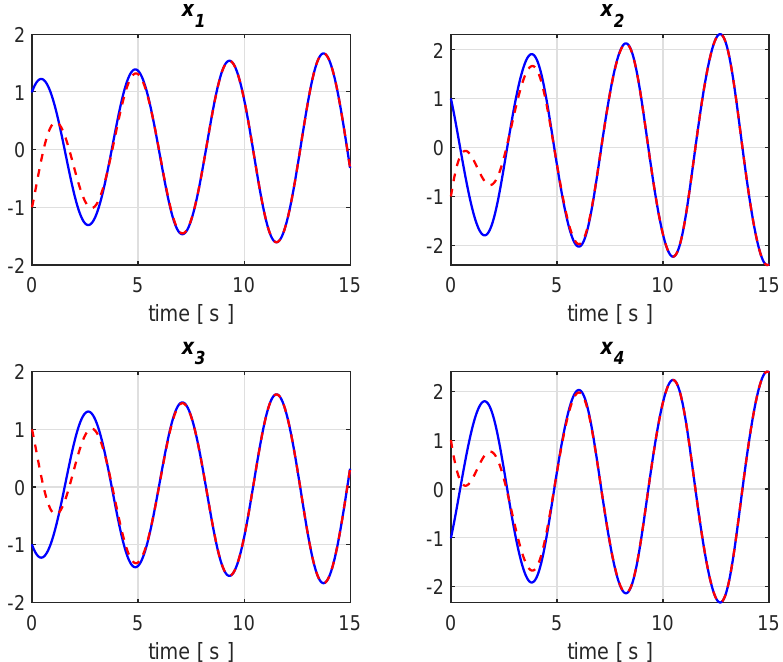
Figure 1. Simulation result without disturbances with states and estimated states in blue and red, respectively.